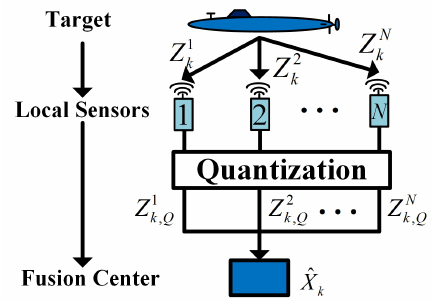
Figure 1. Distributed fusion architecture for target tracking with quantized